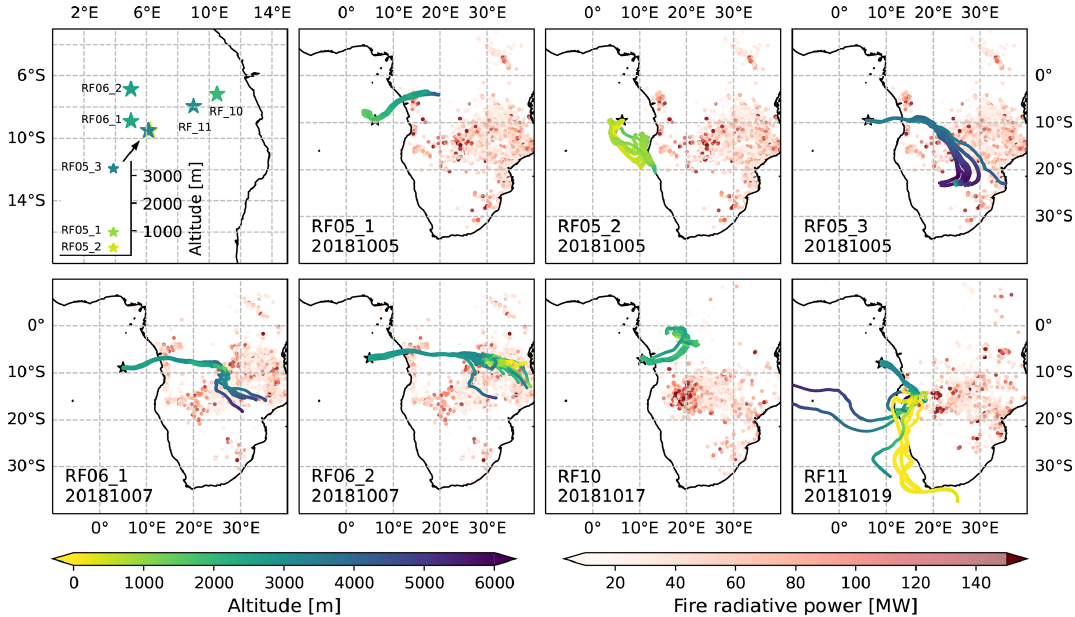
Figure 1. Upper left panel: overview of the flight locations during ORACLES 2018 investigated in this study. All other panels: 7d back- trajectories and fire radiative power from MODIS 6 Collection Active Fire Detections (MCD14ML) at the end day of the trajectory (only data with confidence > 50% are used